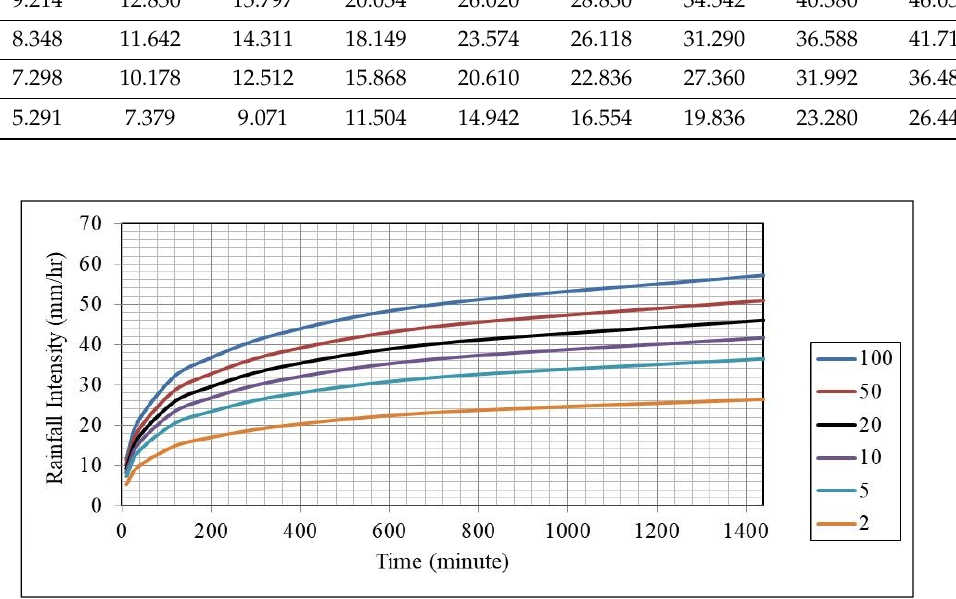
Table 7. Depth of rainfall for different return periods of the study station.